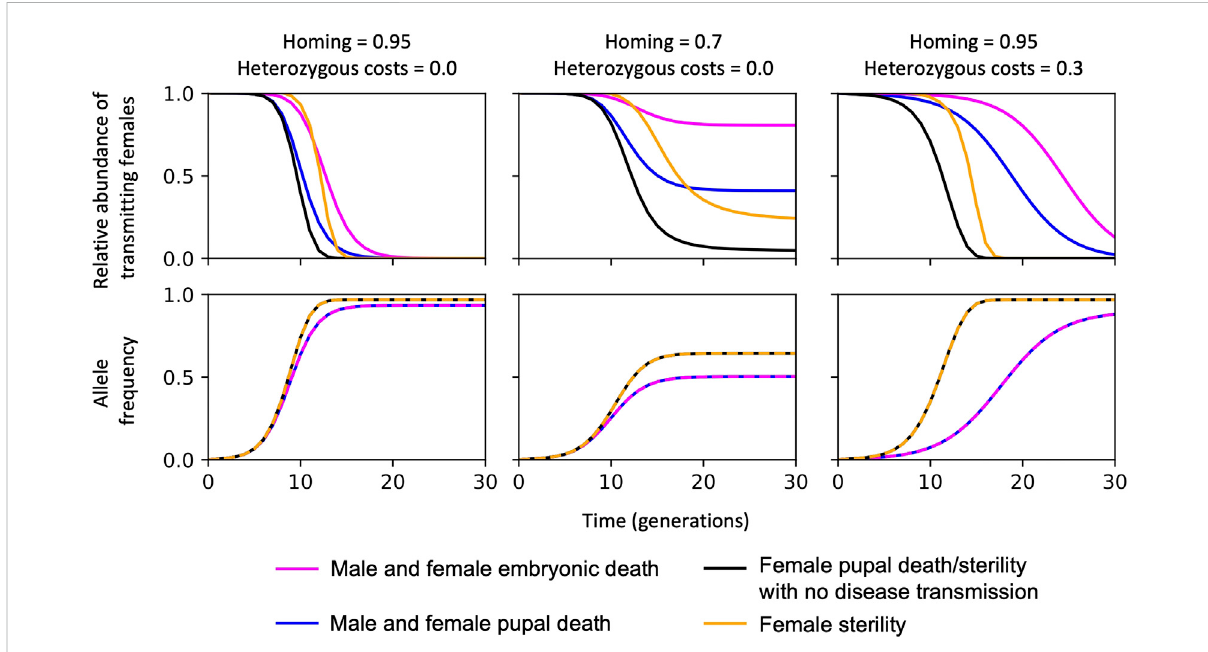
FIGURE 1 The ef fi ciency of self-sustaining CRISPR-based suppression gene drive systems with different gene targets to reduce disease-transmitting mosquitoes. In each case, the CRISPR-gene drive construct is inserted into a haplo-suf fi cient site, assuming homozygotes are either completely inviable with death occurring: (i) at the embryonic stage ( “ Male and female embryonic death ” ); (ii) as pupae, or at the pupal-adult eclosion boundary, i.e., no adults emerge ( “ Male and female pupal death ” ); (iii)injust thefemalesas pupae/pupal-adult eclosion boundary, equivalent to all females survivingbuthavingnoabilitytotransmitmalariaorreproduce “ femalepupaldeath/sterilitywithnodiseasetransmission ” ;or “ femalesterility ” withno deaths occurring such that females can still transmit malaria but cannot reproduce. Summary of fi ndings reported in (Deredec et al., 2011; Burt and Deredec, 2018) using a non-spatial model and parameterisation from (Burt and Deredec, 2018; Kyrou et al., 2018; Hammond et al.,